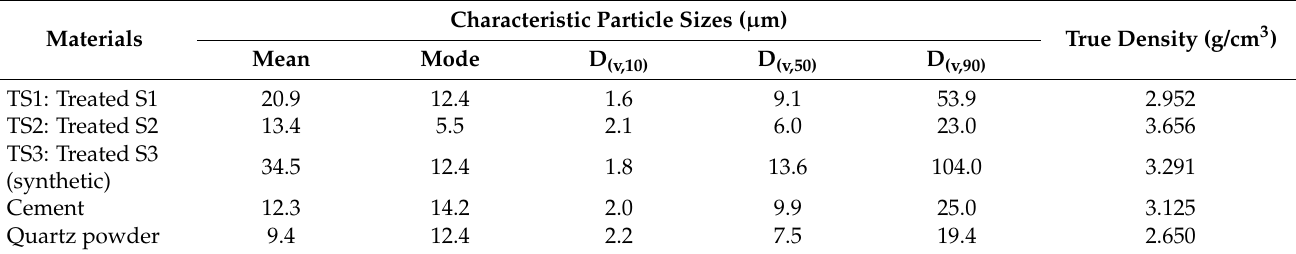
Table 2. Characteristic particle sizes and true density of treated slags (after milling), cement and quartz.